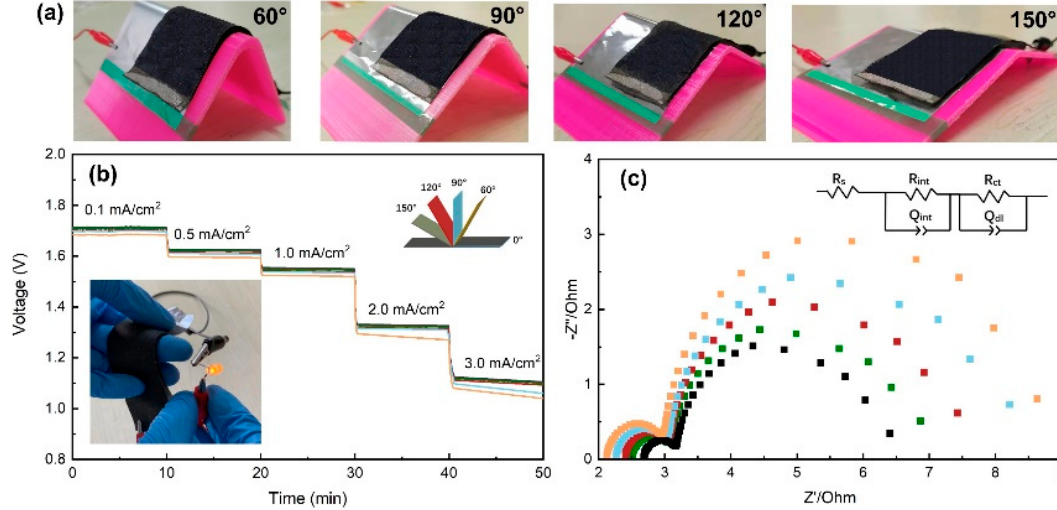
Figure 5. ( a ) Al-air batteries at different bending angles. ( b ) Rate discharge profiles and ( c ) EIS plots for Al-air batteries at different bending angles. Table 1. The resistance values of the equivalent circuit elements based on EIS measurements of Al-air batteries. Element Flat